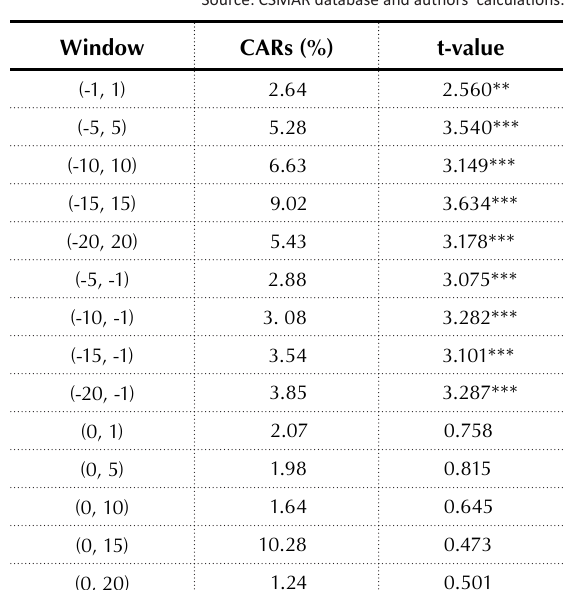
Table 4. Break-down of cumulative abnormal returns